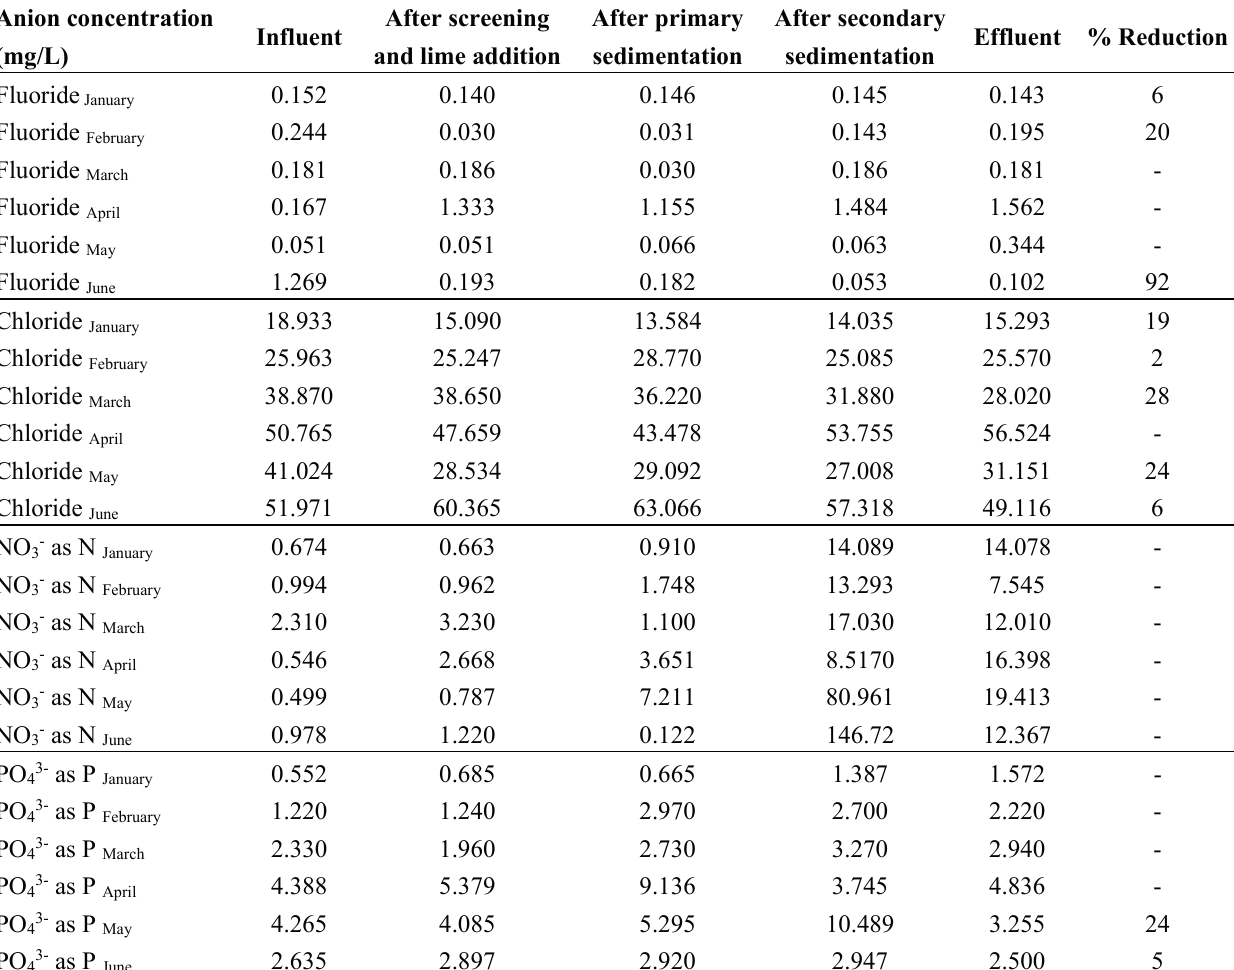
Table 2. Concentrations of anions through major stages of the Thohoyandou